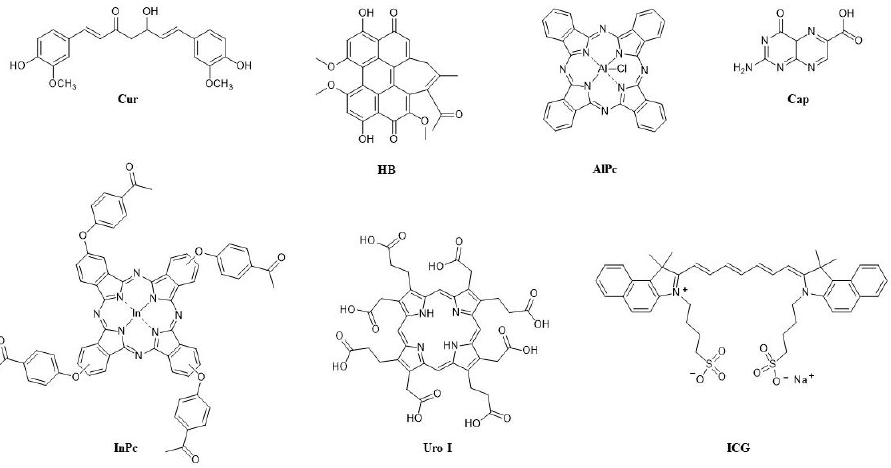
Figure 6. Structures of the PSs used in combination in PACT/PDI and their